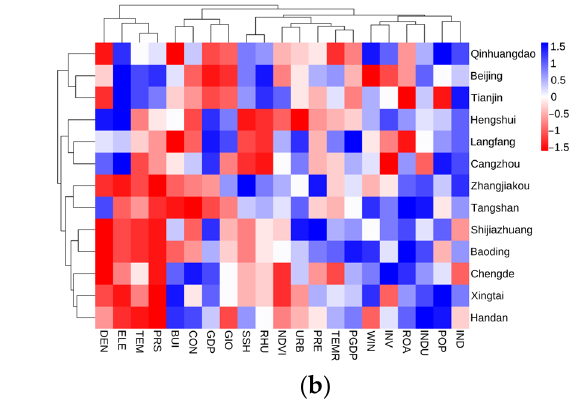
Figure 4. Heatmaps of factors affecting PM 2.5 concentrations in the BTH. ( a ) Ranking of %Inc MSE;